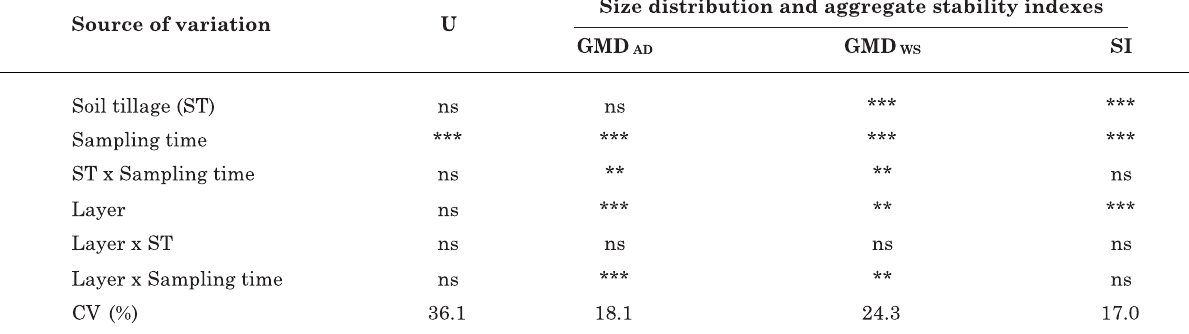
Table 2. Analysis of variance (ANOVA) for size distribution and aggregate stability indexes, determined in two layers on five sampling dates in the tenth year under five tillage systems and five mineral nutrient sources